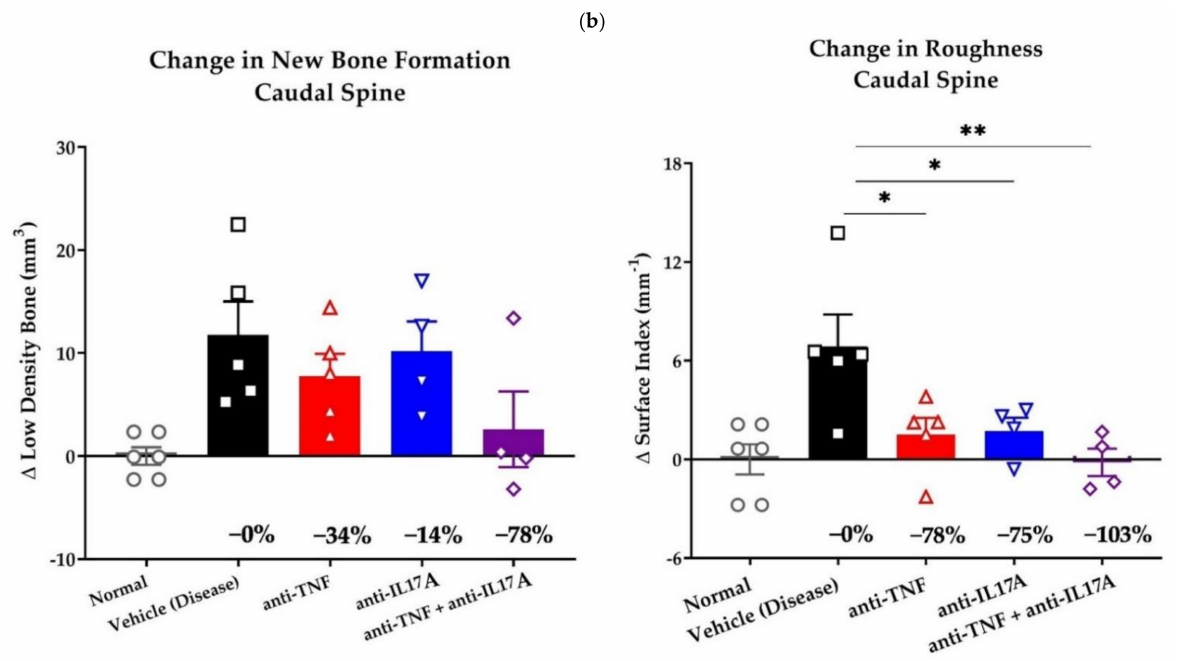
Figure 3. TNF and IL-17A dual blockade therapy affects bone remodeling in axial joints. ( a ) Repre- sentative micro-computed tomography (CT) image of the Caudal 3-Caudal 4 (Ca3-Ca4) vertebrae of HLA-B27/hu β 2m transgenic rats who were treated five weeks with anti-TNF and anti-IL-17A (8C11 and B6-17, n = 4), anti-TNF (8C11, n = 5), anti-IL-17A (B6-17, n = 4), or vehicle control ( n = 5). ( b ) Scoring of micro-CT images of Ca3-Ca4 vertebrae of age and gender matched non-diseased rats and the three treatment modalities compared to vehicle control. Compared to vehicle control, all three treatment modalities showed numerical, but non-significant, decreases for new bone proliferation and a significant decreases for roughness (anti-TNF, p = 0.019; anti-IL17A, p = 0.036; dual blockade, p = 0.004). The dual blockade therapy group showed the strongest decreases ( − 78% for new bone formation and − 103% for roughness). *, p ≤ 0.05; **, p ≤ 0.01.